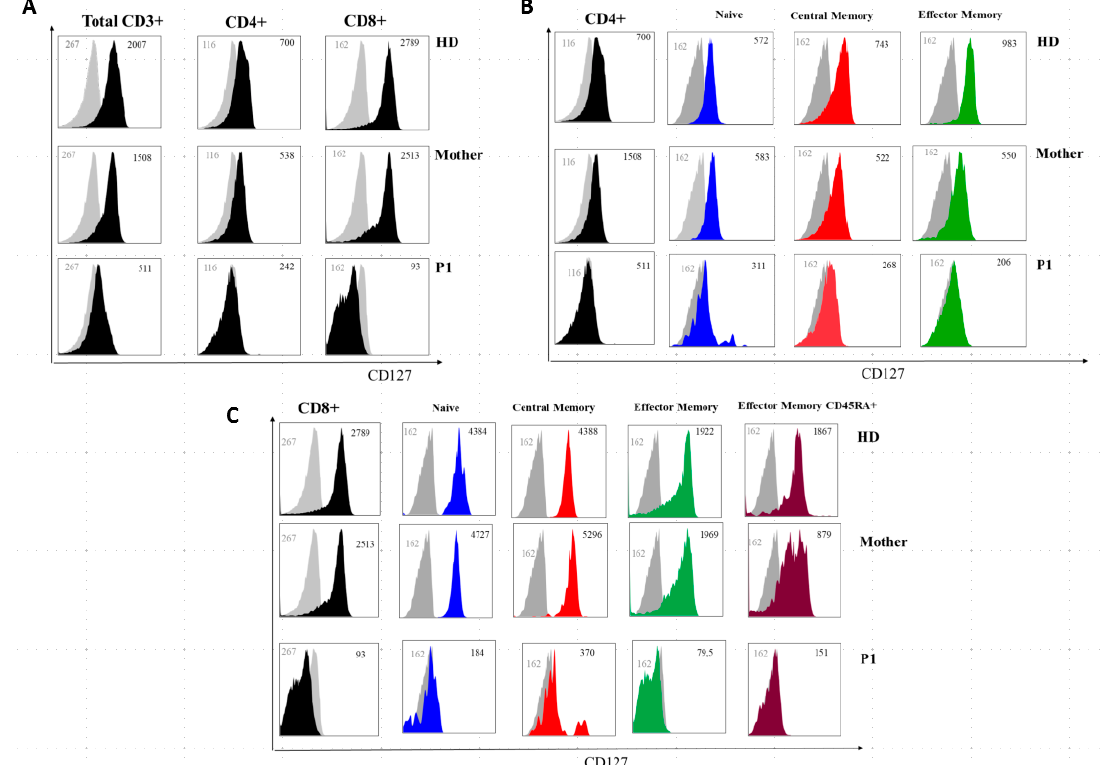
Figure 5. IL7R α (CD127) surface expression on T-cell subsets from a healthy donor, P1, and the patient’s mother. ( A ) Grey histogram plots represent signals from isotype control staining. Note that total CD3 + , total CD4 + , and total CD8 + uniformly express reduced IL7R α in P1 and are slightly reduced in the mother. ( B , C ) IL7R α (CD127) surface expression of T-cell subsets of a healthy donor, the mother, and P1. Grey histogram plots represent signals from isotype control staining. Note that total CD4 + ,